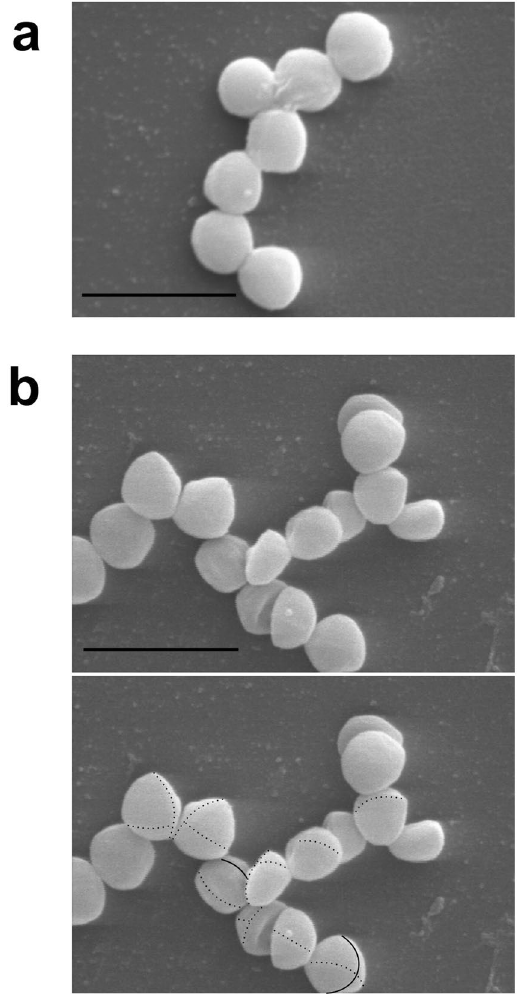
Figure 2. Phenotype of the LytU deficient mutant. ( a ) Scanning electron micrograph of the wild-type S. aureus Newman control. Scale bar, 2 µ m. (b) On top an image of LytU-deficient Newman strain mutant cells without markings and on the bottom the same picture with markings. Scale bar, 2 µ m. Sites of active septa are marked with thin solid lines while the previous cell division line and the one before that are marked with thin dashed lines. While sites of cell division (septa) and daughter cells filling up to spheres were abundantly present in the wild type sample as well as in the mutant sample it was very hard to find any evidence on the location of the previous cell division planes in the control sample. For the mutant strain sample adjusting focus and magnification in EM made tracking of the traces of the previous cell division sites easier than what can be visualised in any still photograph. It should be noted that the position of the next cell division plane in S. aureus is independent of the previous one. Therefore, not every cell in the frame has the latest division circle, or a part of the one before, detectable on the front surface (possible area of detection being less than half of the actual full cell surface). Transmission EM study did not reveal any differences between the wild type and LytU mutant and the pictures are thus not